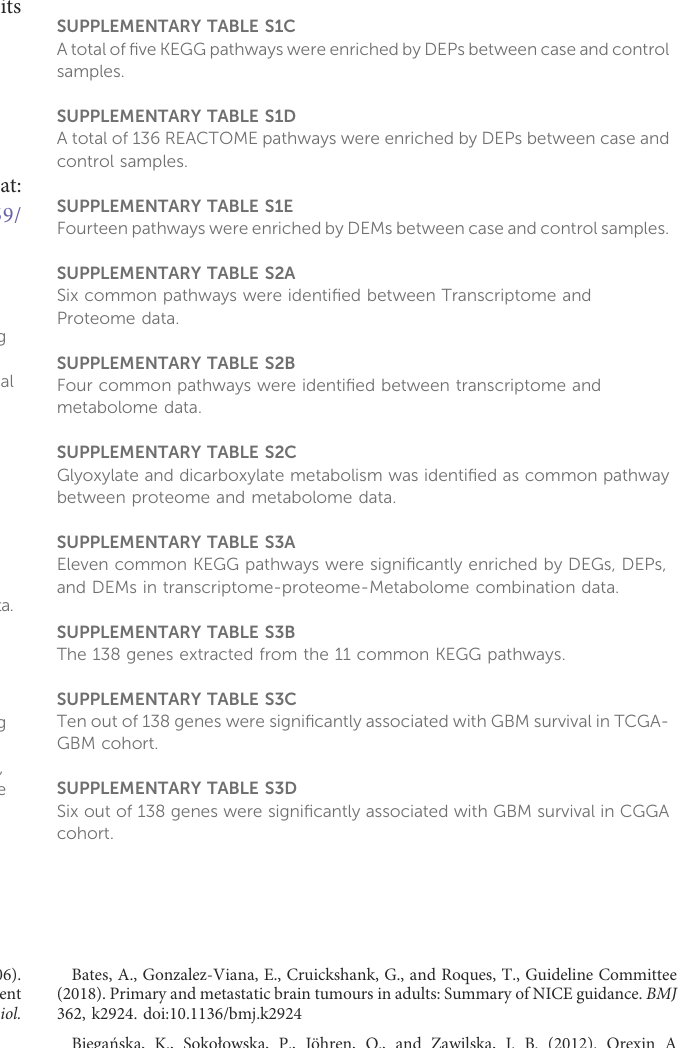
samples. SUPPLEMENTARY TABLE S1B Eleven KEGG pathways were enriched by DEGs between case and control samples.